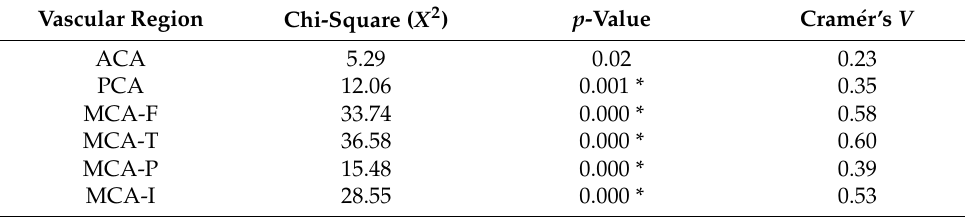
Table 2. Chi-Square results (presence of FHVs and hypoperfusion in PWI). Vascular Region Chi-Square ( X 2 ) p -Value Cram é r’s V ACA 5.29 0.02 0.23 PCA 12.06 0.001 * 0.35 MCA-F 33.74 0.000 * 0.58 MCA-T 36.58 0.000 * 0.60 MCA-P 15.48 0.000 * 0.39 MCA-I 28.55 0.000 *